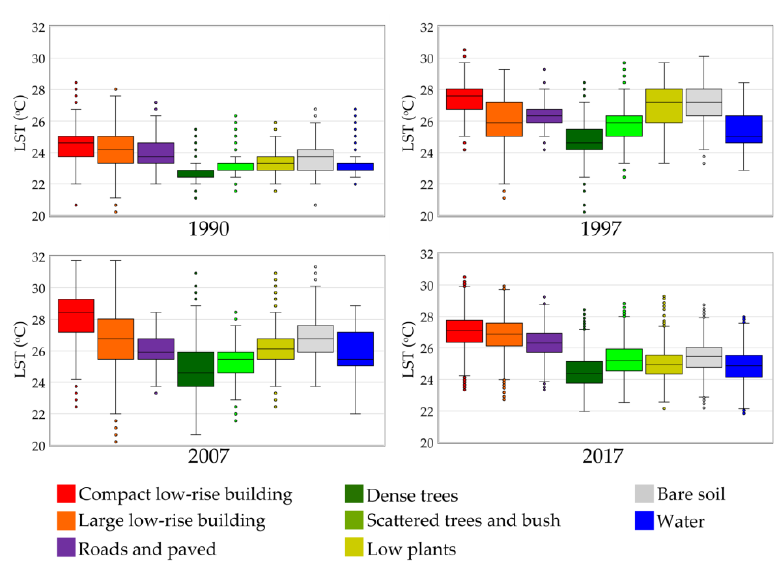
Figure 9. Box plots of land surface temperature (LST) for different LCZ category.